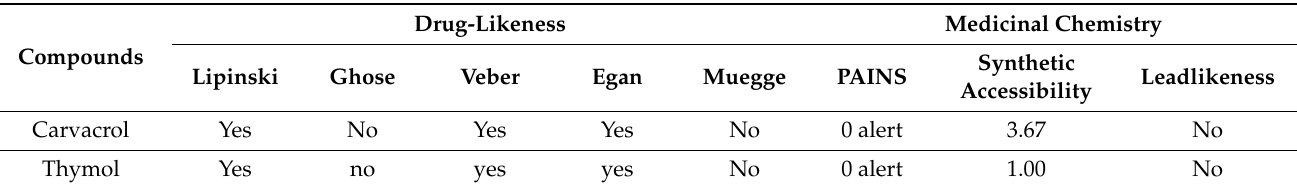
Table 9. Drug-likeness prediction and Medicinal Chemistry of thymol and carvacrol. Drug-Likeness Medicinal Compounds